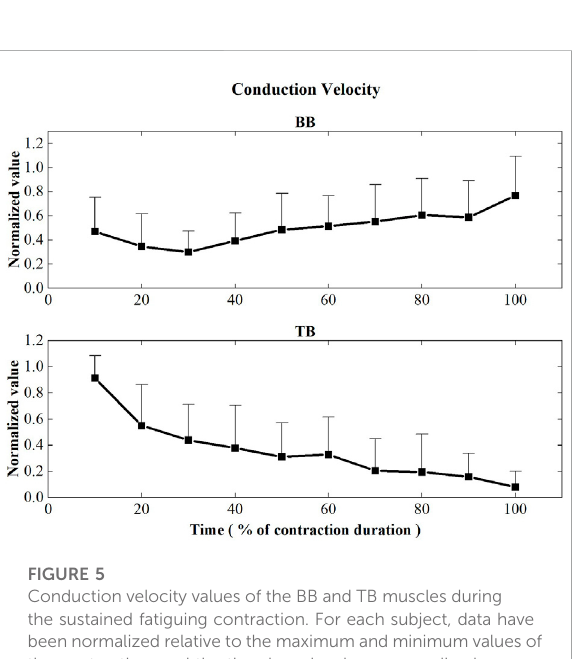
FIGURE 5 Conduction velocity values of the BB and TB muscles during the sustained fatiguing contraction. For each subject, data have been normalized relative to the maximum and minimum values of the contraction, and the time base has been normalized to 100%.